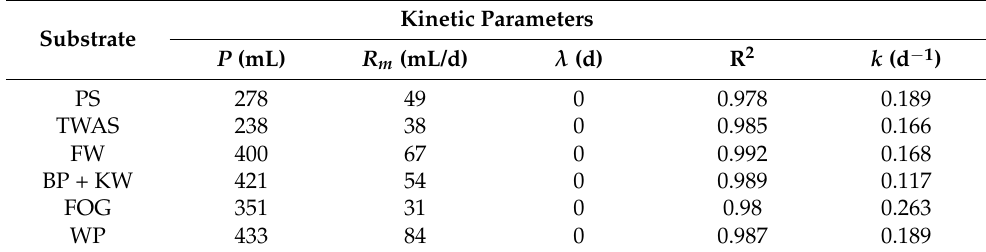
Table 3. Kinetics parameters of the Gompertz and first-order